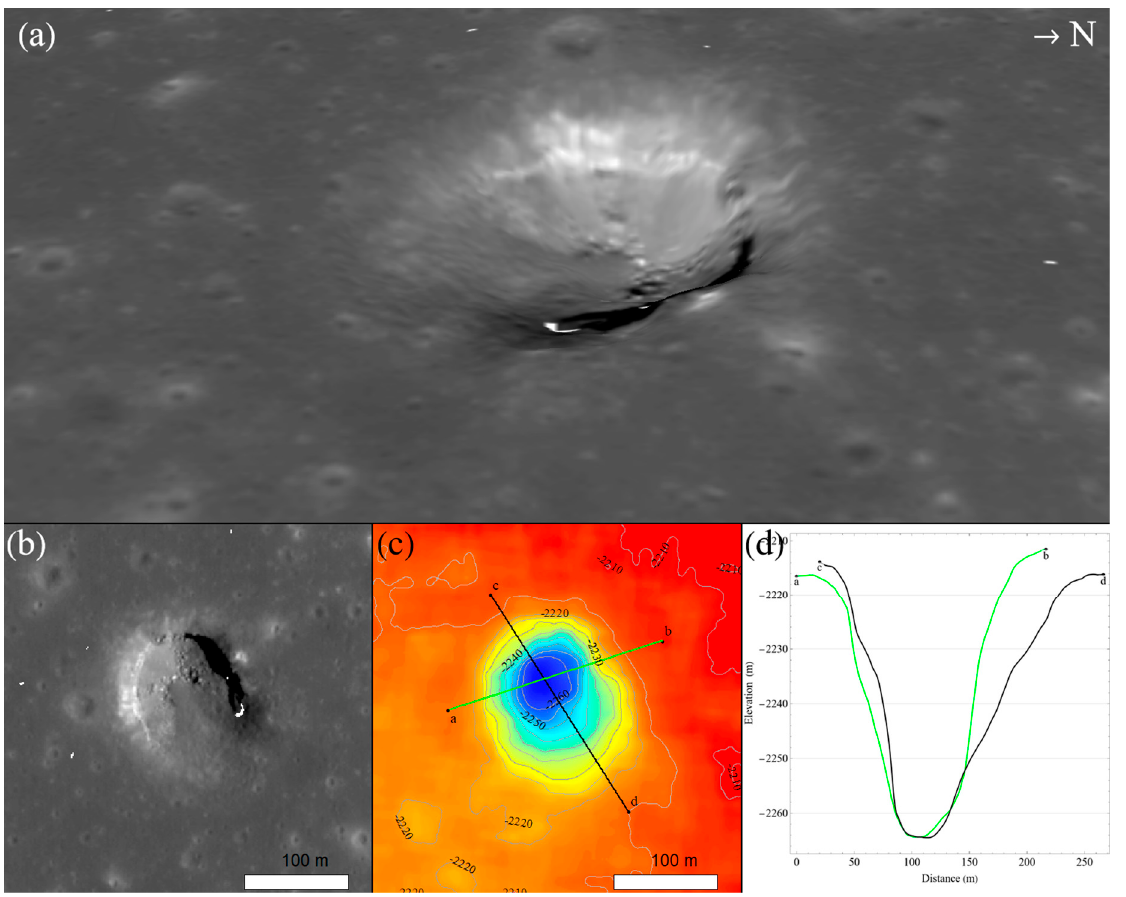
Figure 12. Pit crater (0.917 ◦ S, 48.660 ◦ E) in the central Fecunditatis. ( a ) 3D image (real elevation values are used); ( b ) NAC orthoimage; ( c ) NAC DTM; ( d ) elevation of the profiles of ( c ). Data source: NAC M1105602888RE and NAC